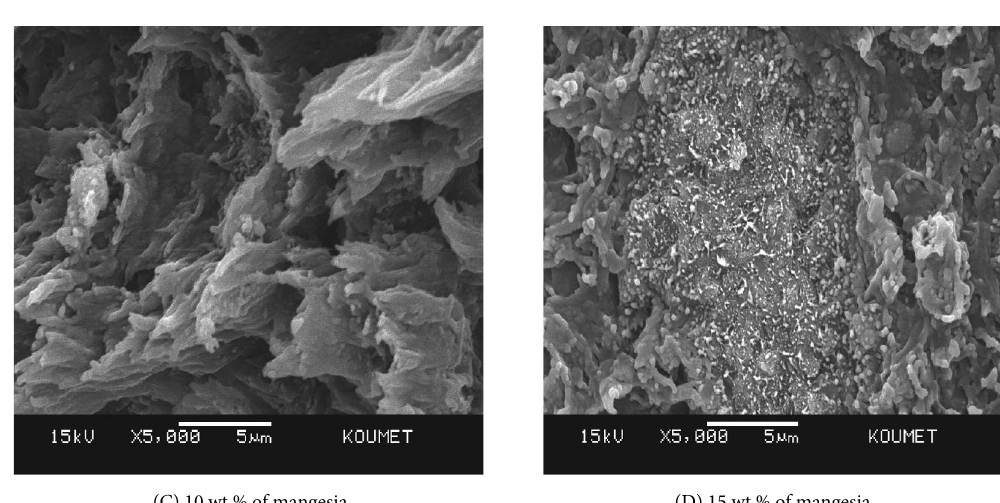
(D) 15 wt.% of mangesia(C) 10 wt.% of